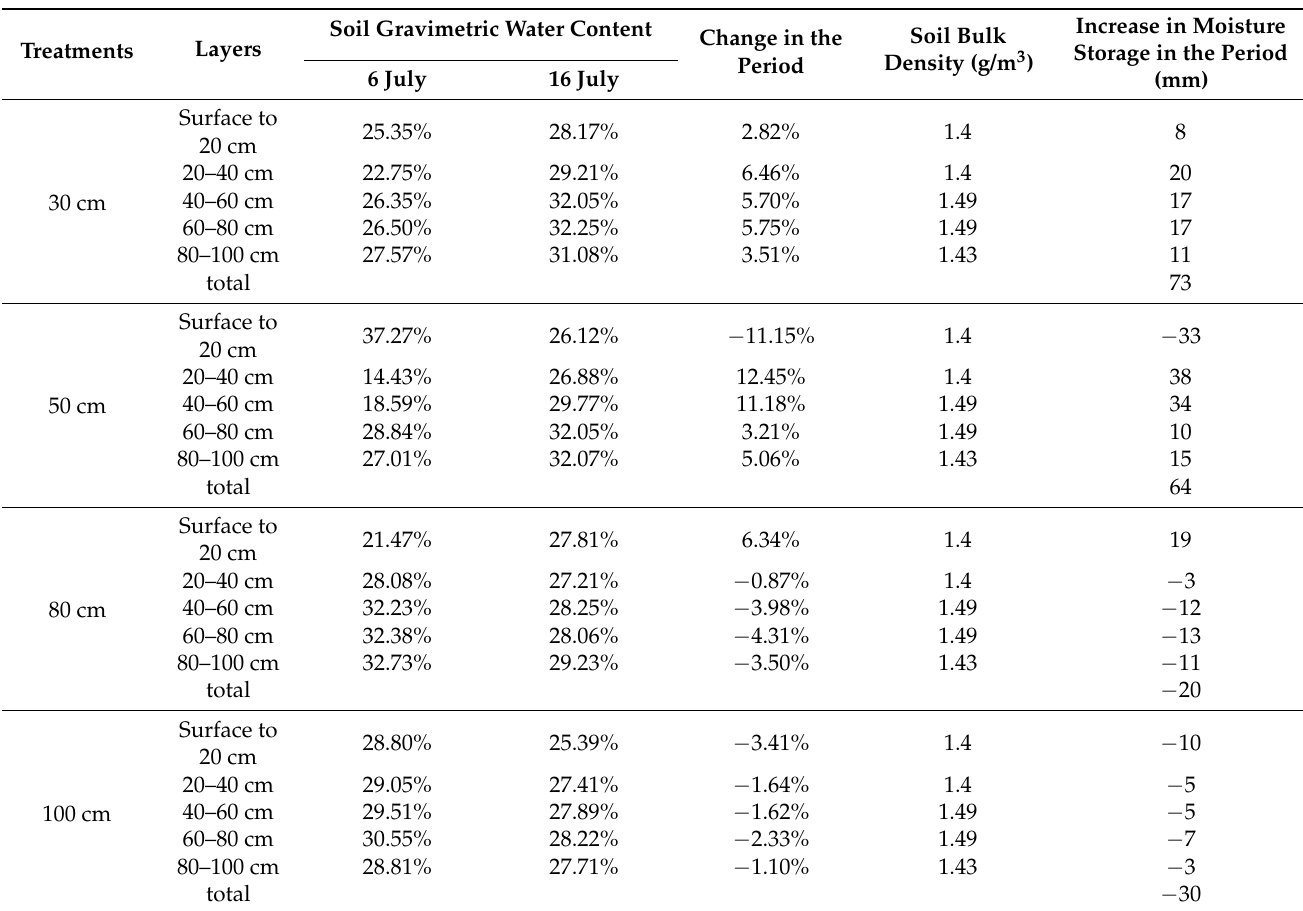
Table 5. Calculation of the moisture storage change after rainfall in the test